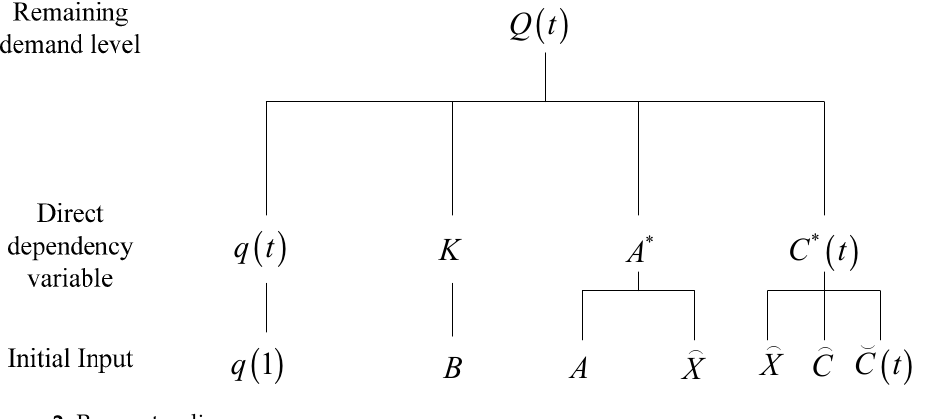
Figure 2. Parameter diagram.